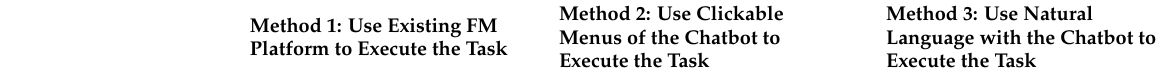
Table 5. Designed tasks for the field